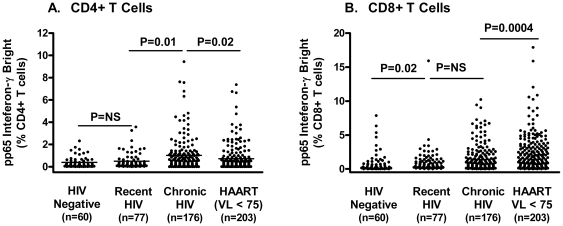
The distribution of pp65 IFN-γ-bright CD4+ and CD8+ T cell responses (background corrected) in four unique groups: (1) HIV-seronegative, CMV-seropositive, (2) acute and recent untreated HIV infection, (3) established chronic untreated HIV infection, and (4) antiretroviral-treated infection with undetectable plasma HIV RNA levels.